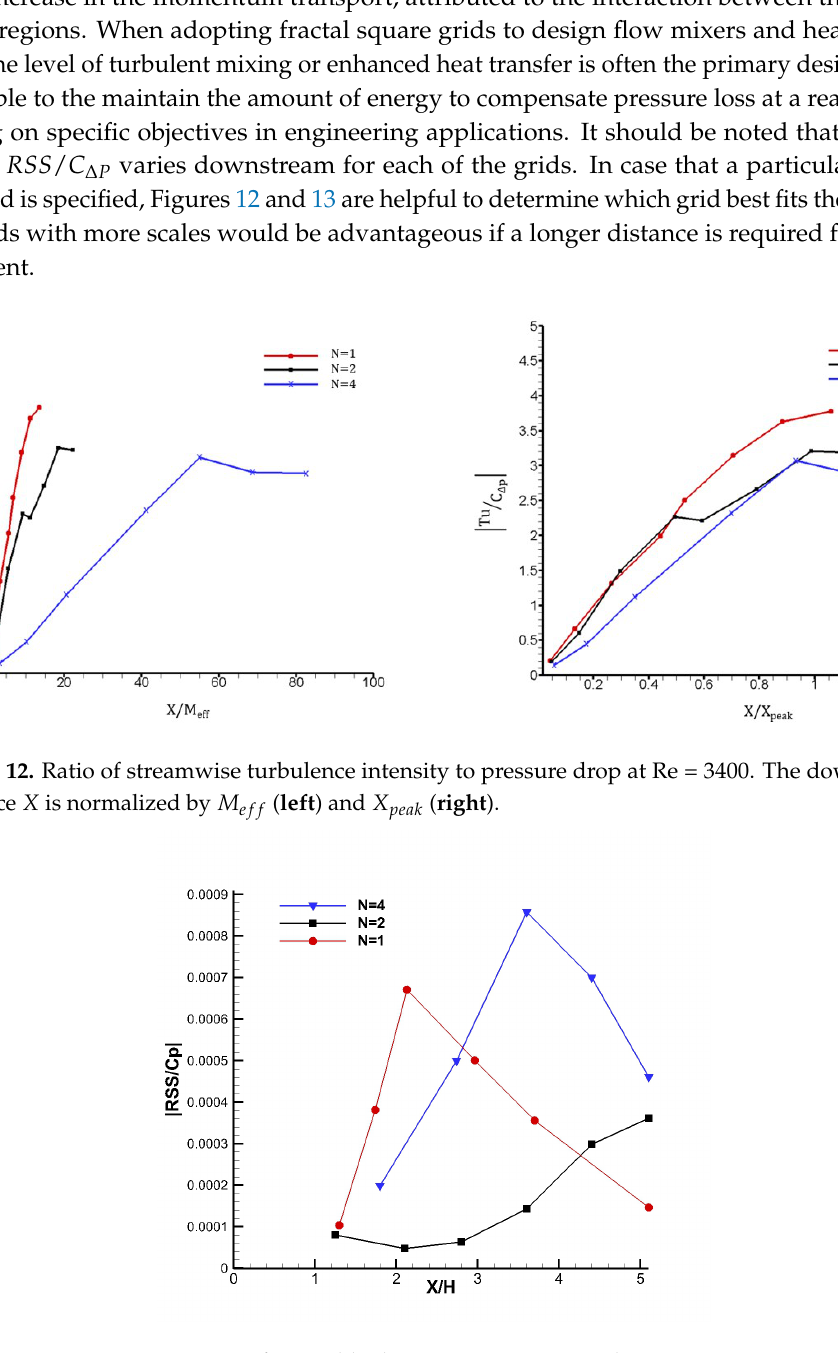
Figure 13. Ratio of Reynolds shear stress to pressure drop at Re =